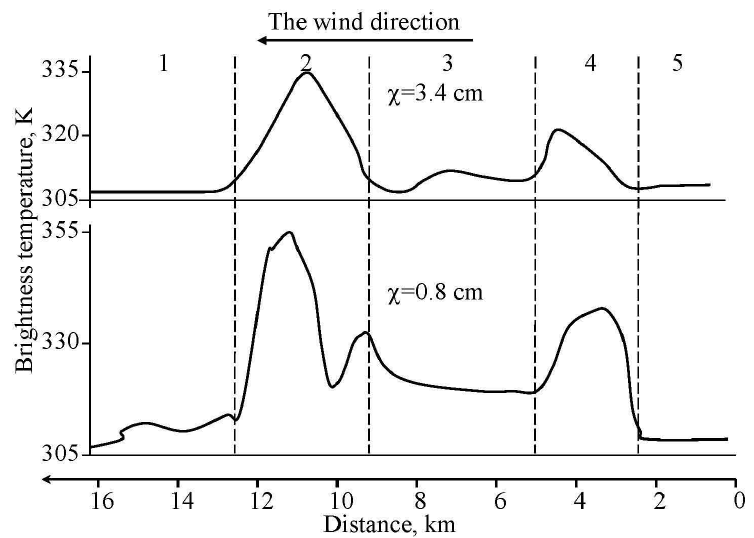
Figure 6. Typical brightness temperature distributions recorded along the IL-18 trace above the active fire pixels. The measurements were made on July 21, 1998 in the Irkutsk region, 75 km north of Irkutsk, a south-taiga forest. Numbers 1–5 identify forest fire zones: 1—smoky area, 2—fire front, 3—burning zone, 4—fire back and 5—forest.